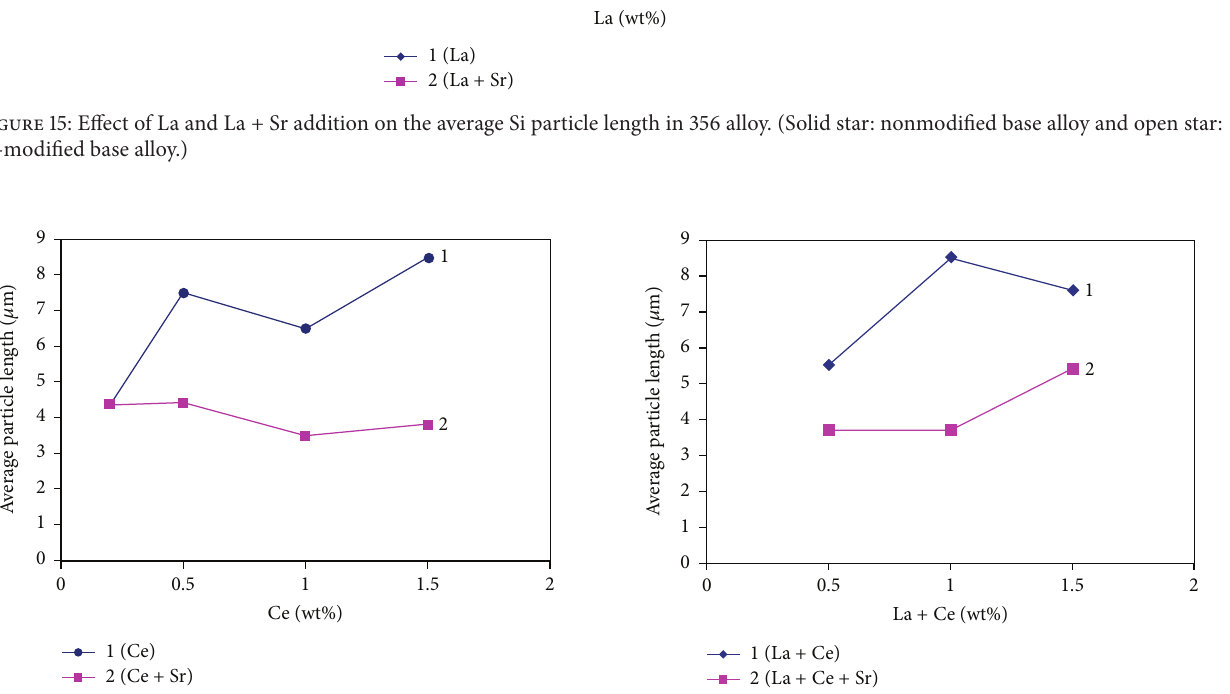
Figure 17: Effect of La + Ce and La + Ce + Sr on the average Si particle length in 356